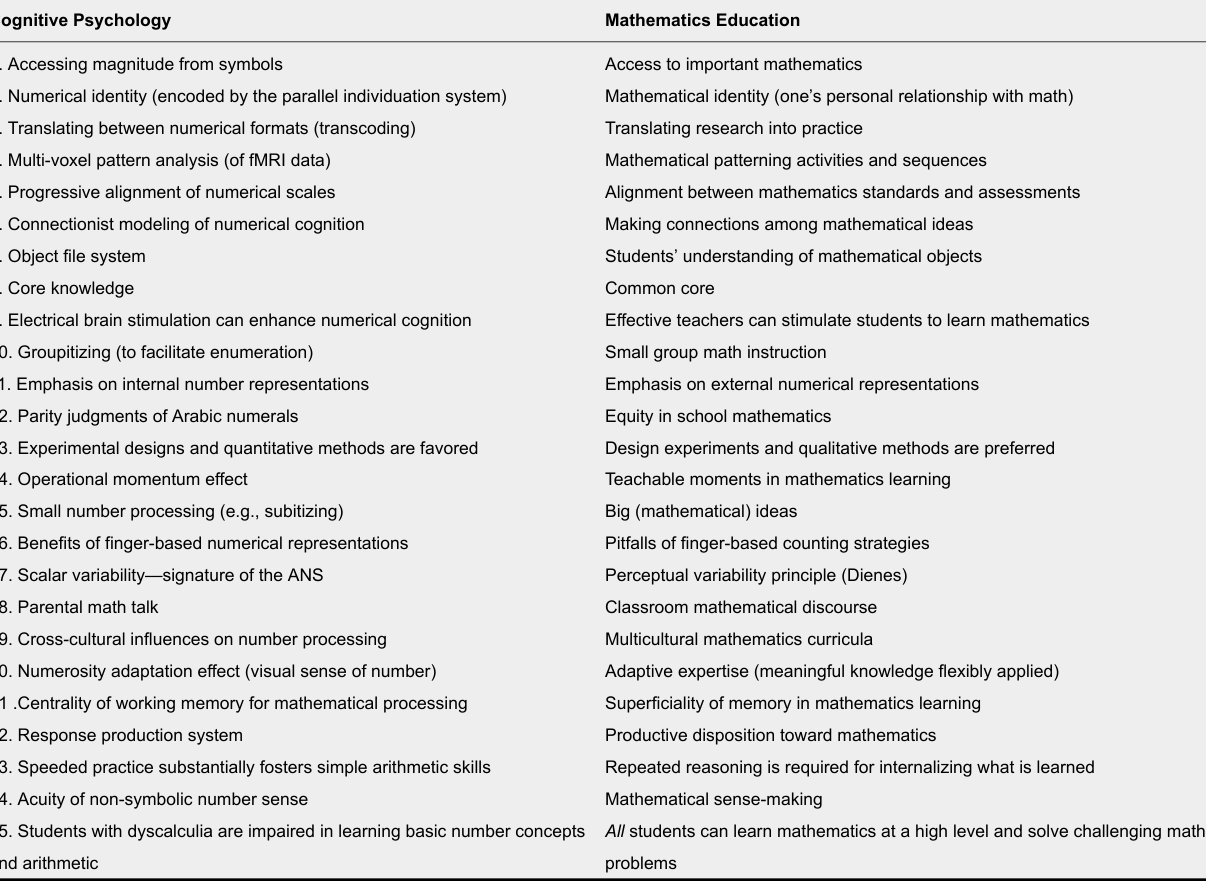
Contrasts Between Cognitive Psychology and Mathematics Education With Respect to the Study of Mathematical Thinking and